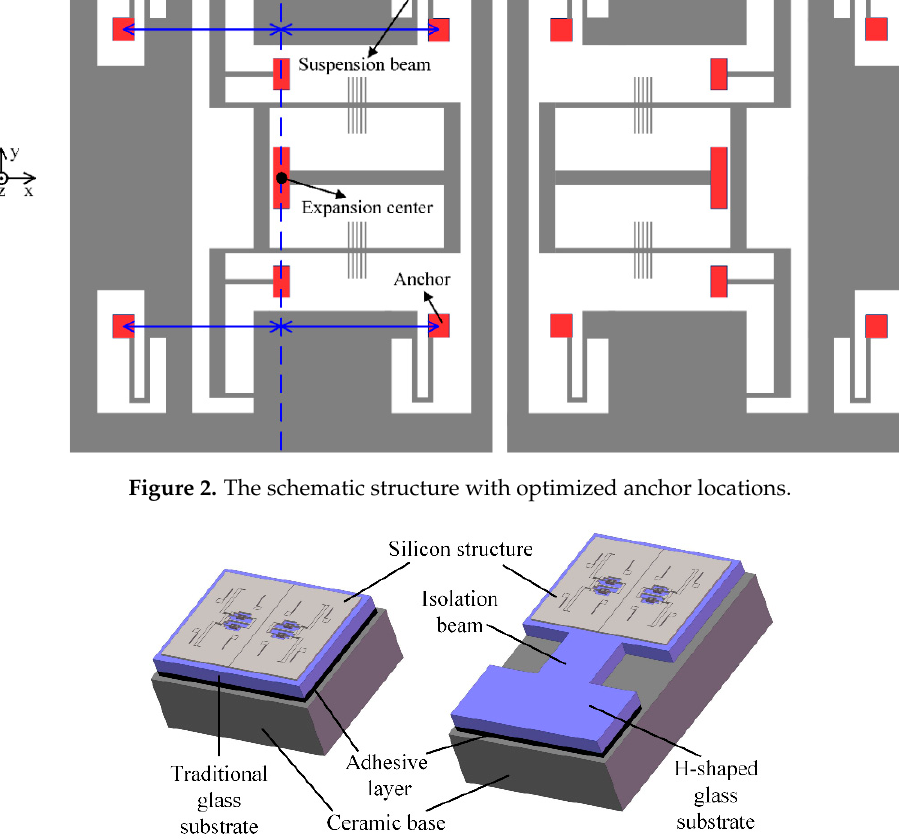
Figure 2. The schematic structure with optimized anchor locations.